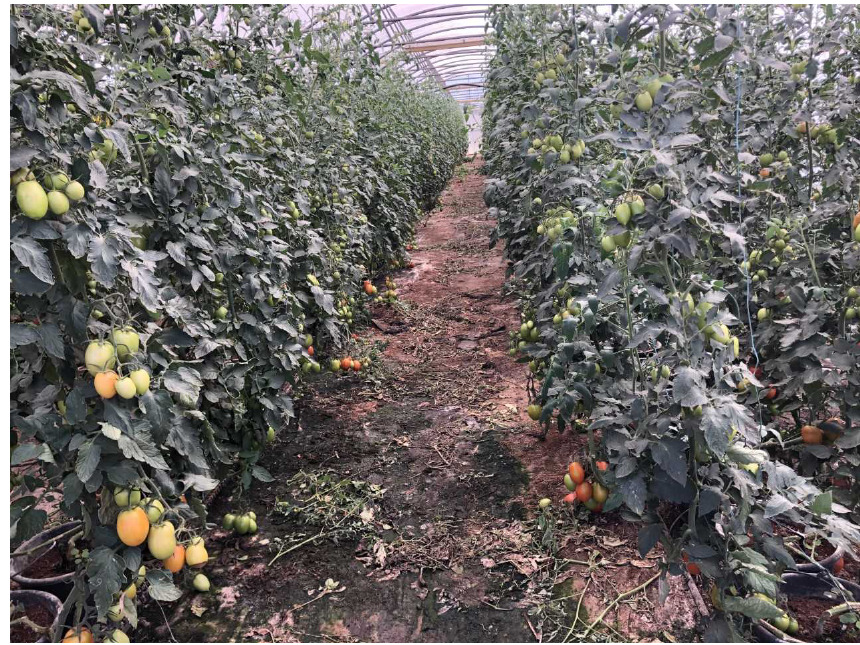
Figure 5. Greenhouses’ entrance.